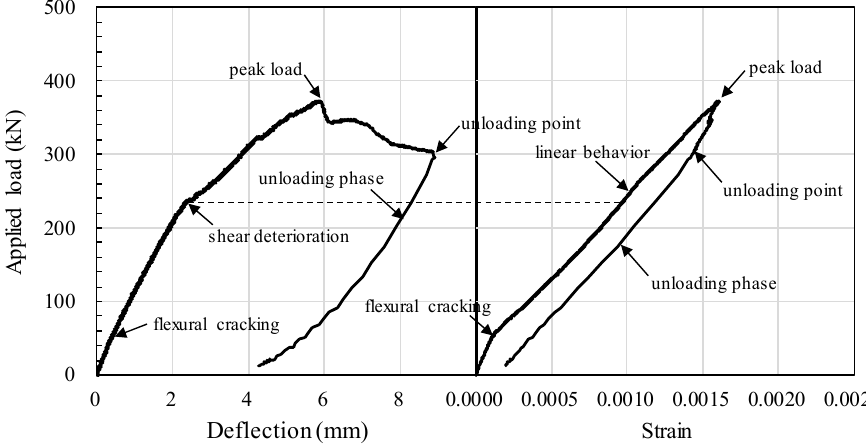
Figure 7. Loading history of a typical shear-critical RC beam (S1-3.0).